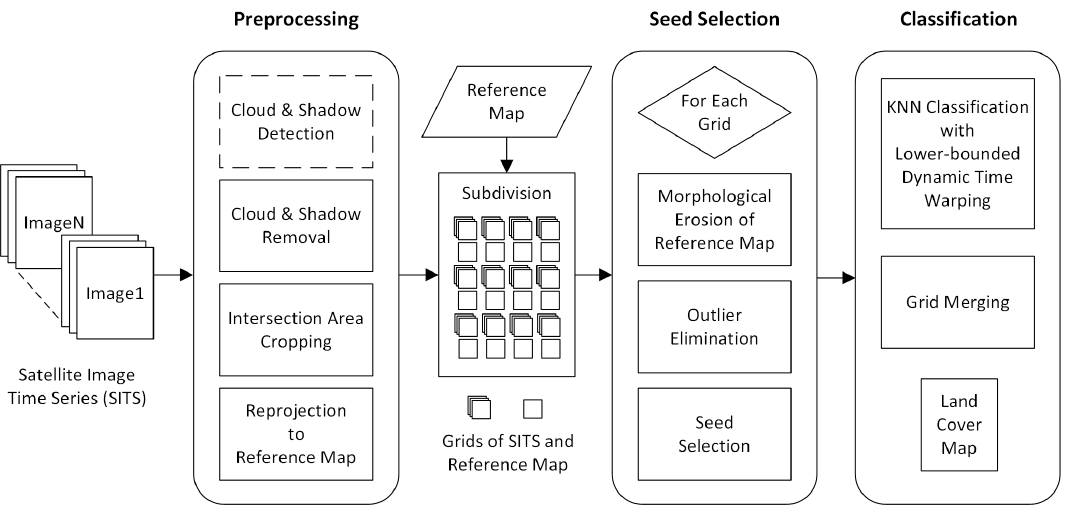
Figure 5. The process of seeded classification of